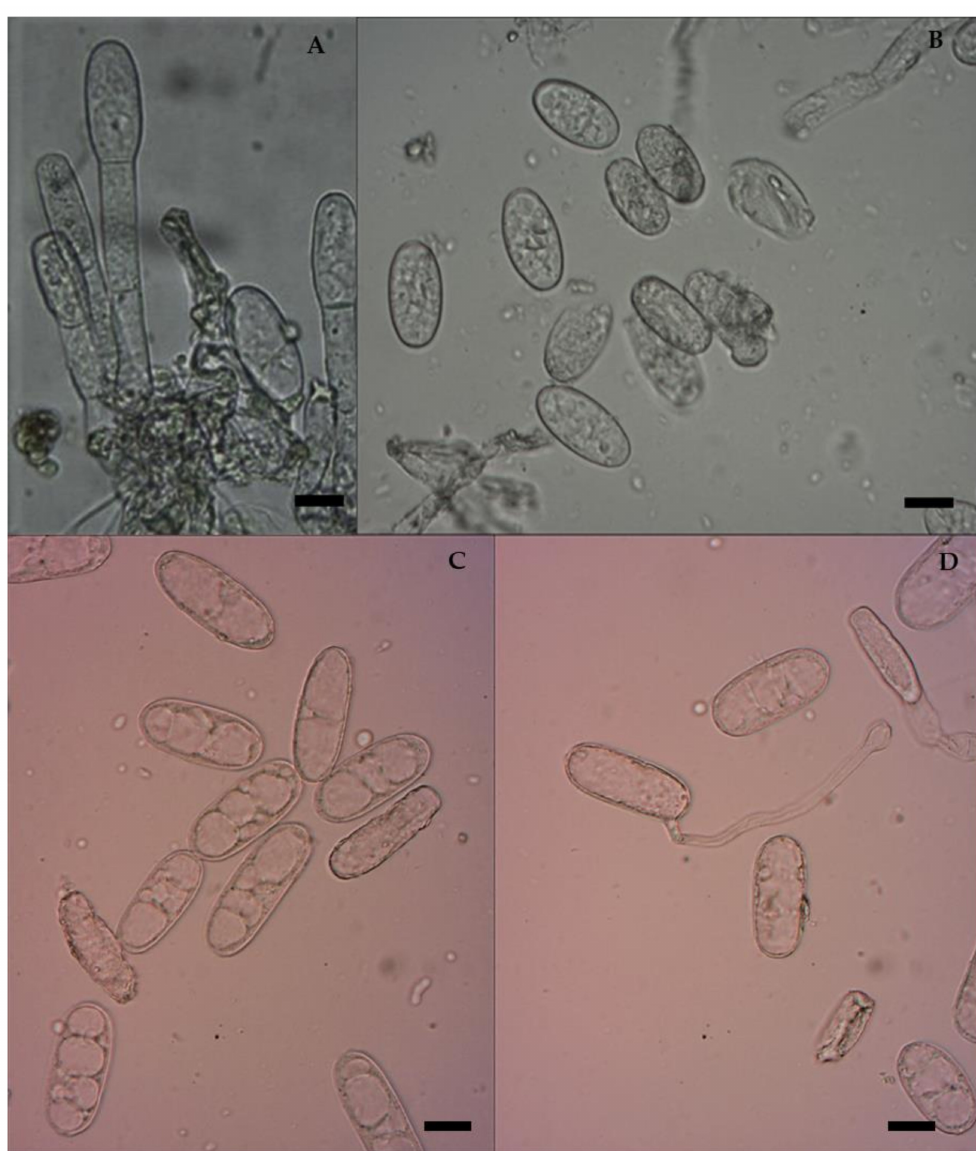
Figure 2. Micromorphological characters of E. pisi . Scale bars = 10 µ m. ( A ) Germinating conidiophore of E. pisi ; ( B ) Young conidia; ( C ) Matured conidia; ( D ) Germination of conidia producing